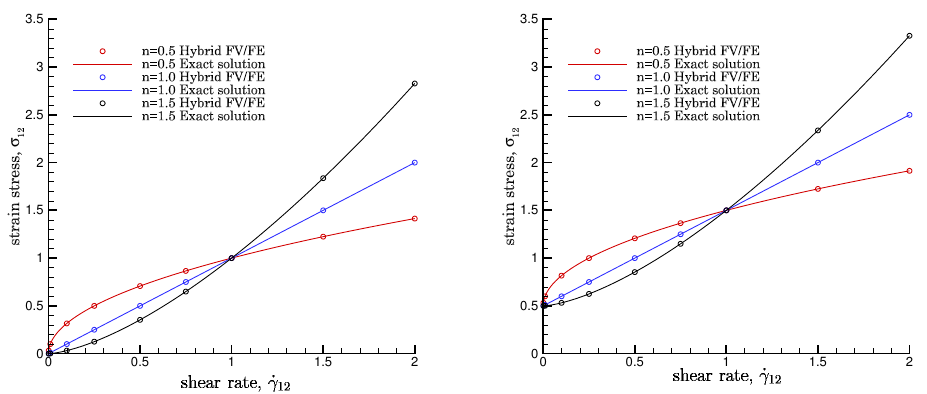
Figure 4. Couette flow of a non-Newtonian fluid. Comparison of the numerical solution obtained using the hybrid FV/FE method (circles) and the analytical solution of the Herschel–Bulkley model (solid line). Yield stress σ y = 0 and σ y = 0.5 are considered on the left and right plots, respectively, the consistency parameter is κ = 1, and the power-law indexes are n ∈ { 0.5,1,1.5 }